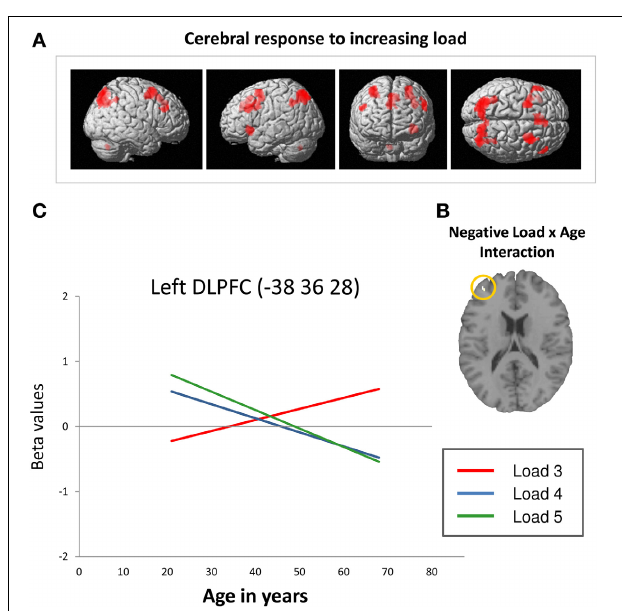
FIGURE 3 | (A) Increasing frontal, parietal and cerebellar activation in response to increasing task load across all participants at a cluster significancethresholdof p < 0 . 05(FWE-correctedformultiplecomparisons). (B) Decreasing retrieval-related DLPFC activation with increasing age in response to increasing task load (negative load × age interaction; p < 0 . 05, FWE-corrected). (C) Linear relation between retrieval-related BOLD signal change (in arbitrary units; Poldrack, 2007) within the left DLPFC ( − 38 36 28; Nagel et al., 2009) and age at CBT load levels 3 (red line), 4 (blue line), and 5 (greenline).Theregressionlinesshowthatactivationintensityincreasedwith increasingageatloadlevel3anddecreasedwithincreasingageatloadlevels 4 and 5 (DLPFC, dorsolateral prefrontal cortex; BA, Brodmann